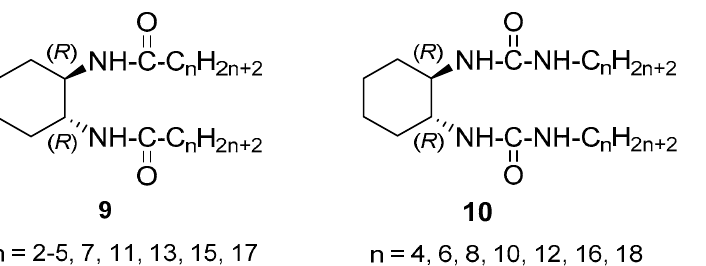
Figure 6. Cyclohexane-based bisamide and bisurea organogelators bearing alkyl chains of differ- ent lengths.